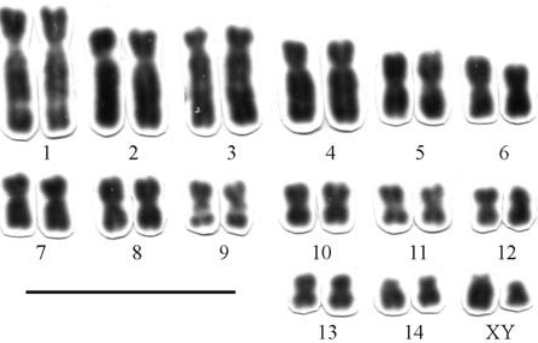
Figure 8 - Karyomorph F conventionally stained with 2n = 30, FN = 56 of P. roberti from Vila Rica (MT). Bar = 10 (cid:1) m.